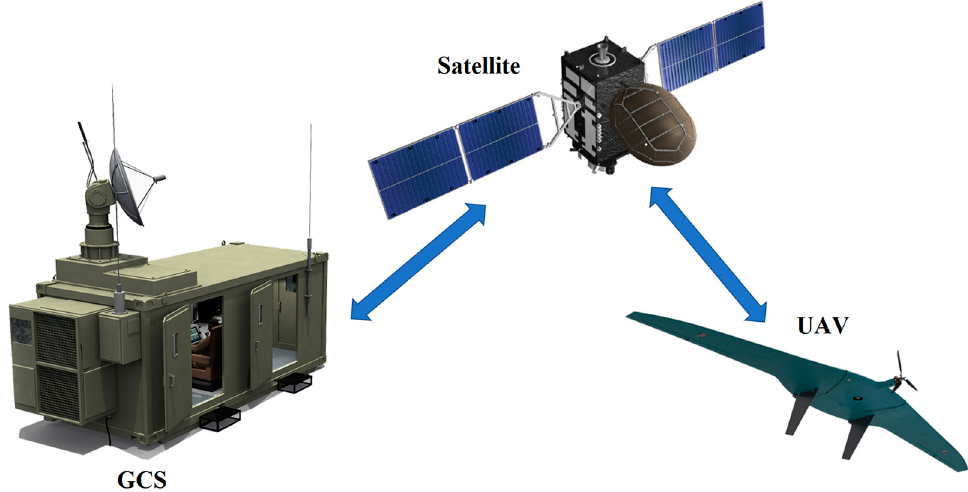
Figure 3. Scheme of communication option “UAV—Sputnik”.